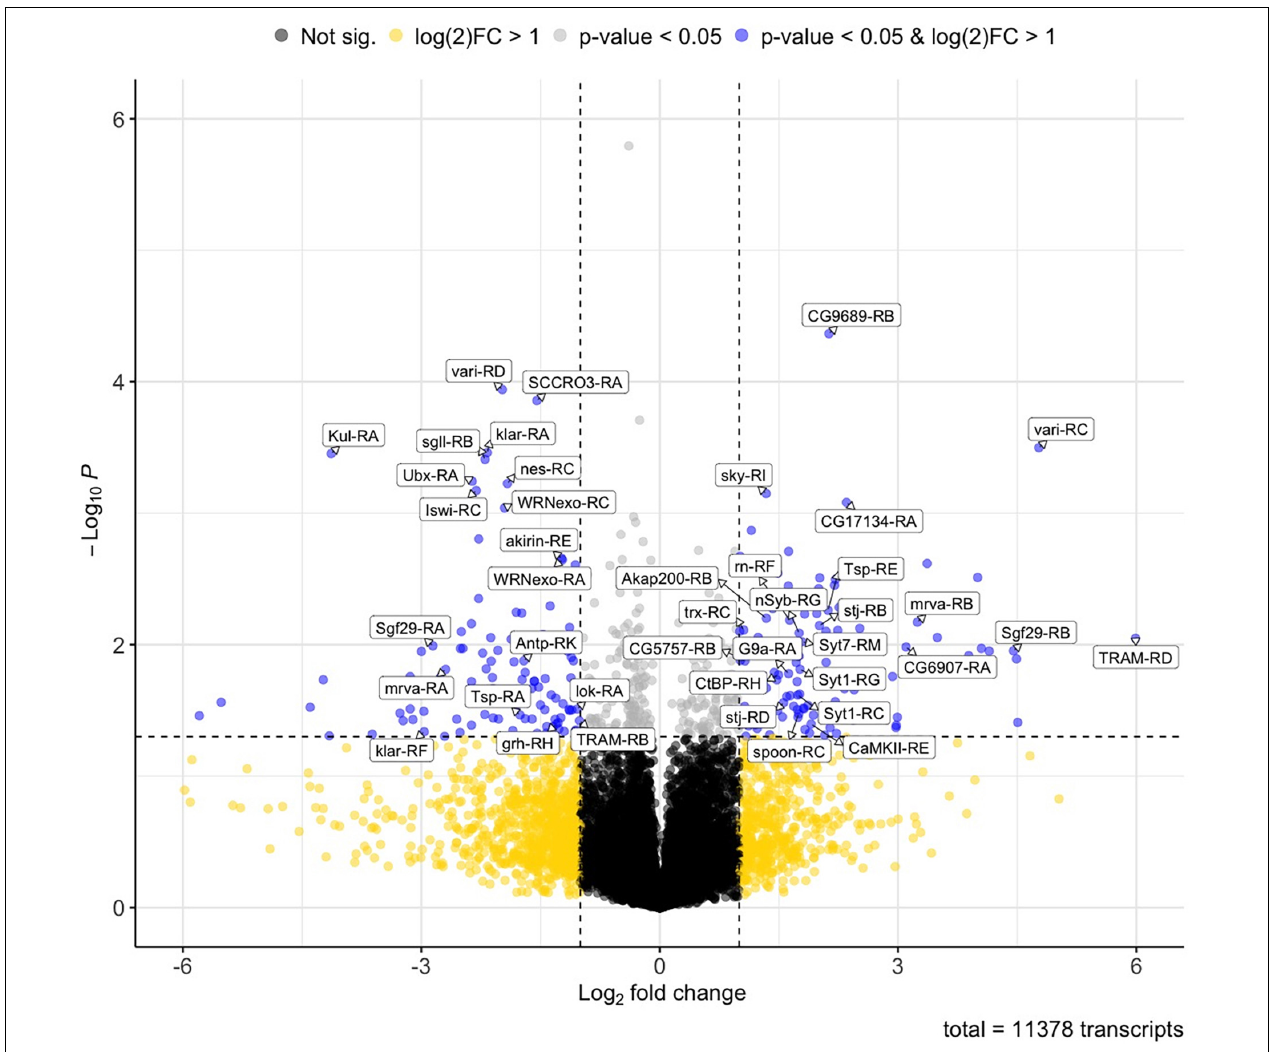
FIGURE 1 | Volcano plot of differentially expressed transcripts induced by chronic alcohol exposure. Volcano plots showing fold change of differential transcript expression [log2 fold change] compared to the inverse of statistical significance [ − log 10 ( P -value)]. Points in black or yellow are transcripts with no significant changes in expression ( P > 0.05). Points in gray and blue correspond to transcripts with significant changes in expression ( P < 0.05). Points in blue correspond to transcripts with significant changes in expression ( P < 0.05) and that display a fold change higher than 2-fold (log2 fold change > 1). Names of genes encoding representative transcripts are labeled in the